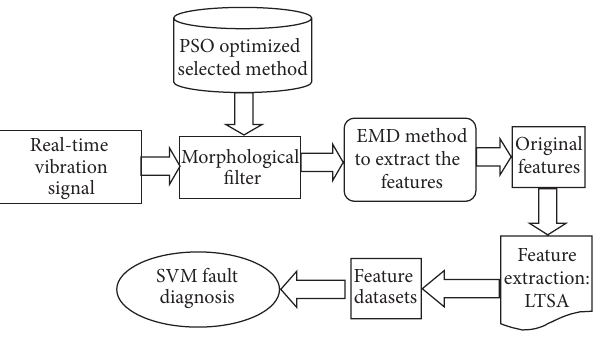
Figure 2: The flowchart of the proposed method.